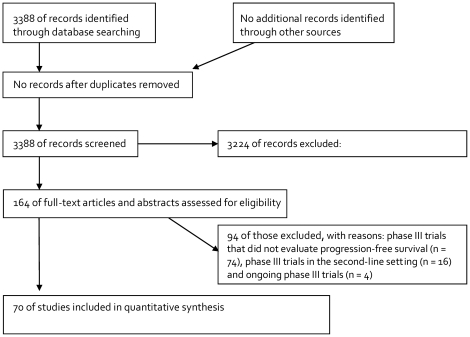
The PRISMA flow chart showing the progress of trials through the review.